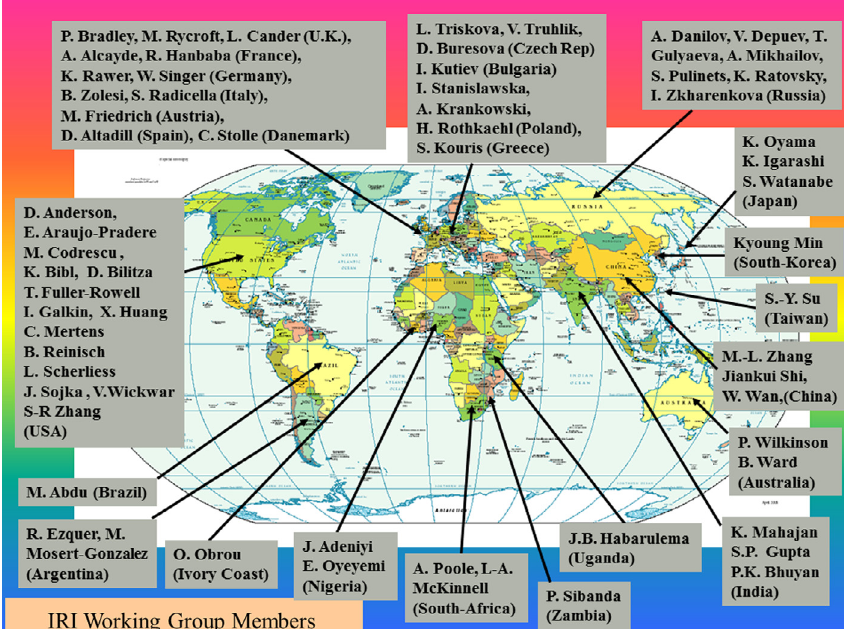
Fig. 1. Global distribution of members of the URSI/COSPAR Working Group for the International Reference